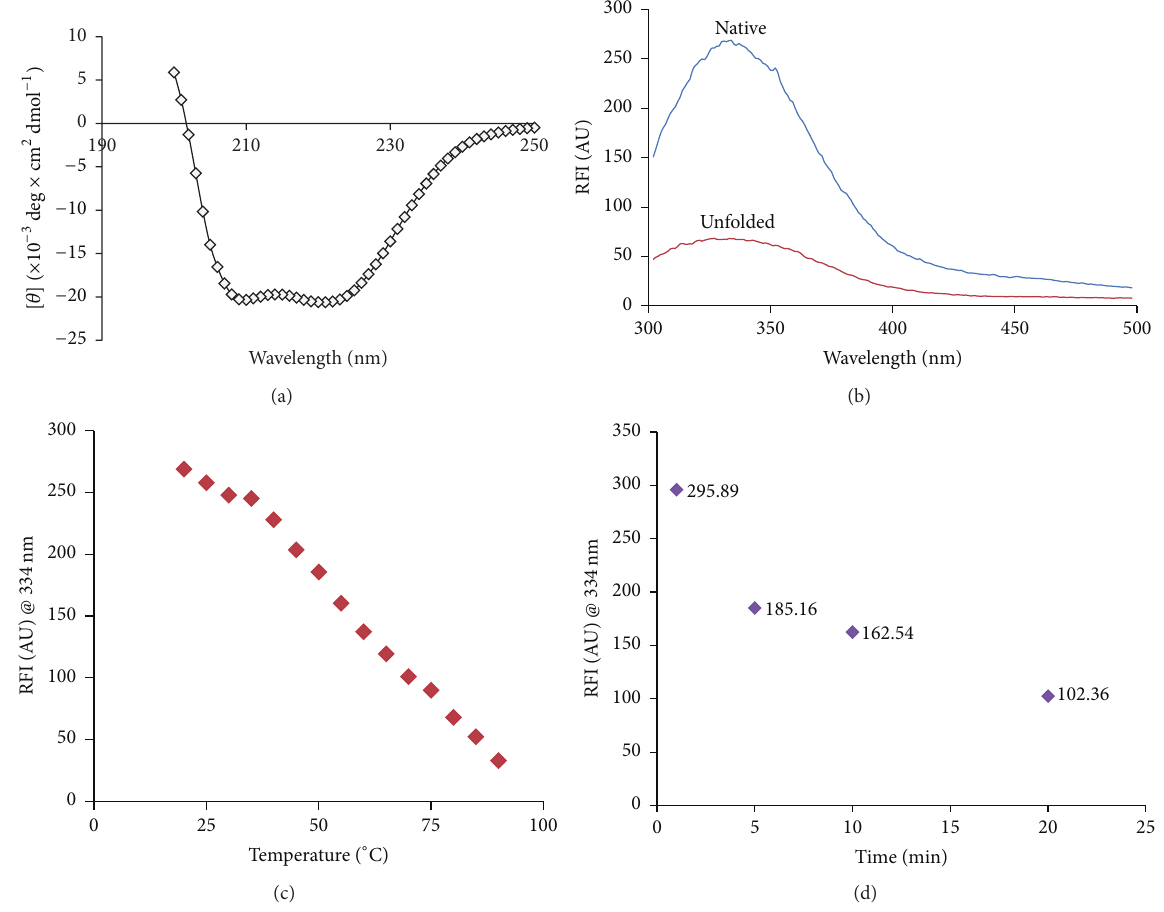
Figure 3: (a) Circular dichroism (CD) spectra of the soluble r Lr IL-10 in the far-UV regions (200–250 nm). CD values are expressed as [𝜃] , mean residue mass ellipticity in units of degree × cm 2 dmol −1 . (b) Intrinsic fluorescence spectra of the purified r Lr IL-10 under native (room temperature) and unfolded (at 80 ∘ C) states. The samples were excited at 280 nm and emission spectra were recorded from 300 nm to 500 nm. RFI (AU) denotes relative fluorescence intensity in arbitrary units. (c) Temperature kinetics of unfolding of r Lr IL-10. Emission spectra of the r Lr IL-10 incubated for 20 min at different temperatures were recorded. Relative fluorescence intensity at 334 nm is plotted as a function of temperature. (d) Time kinetics of unfolding of purified r Lr IL-10 at 60 ∘ C. The purified r Lr IL-10 was incubated at 60 ∘ C for different time points and fluorescence spectra were recorded. The figure shows fluorescence intensity in arbitrary units (AU) at 334 nm at different time